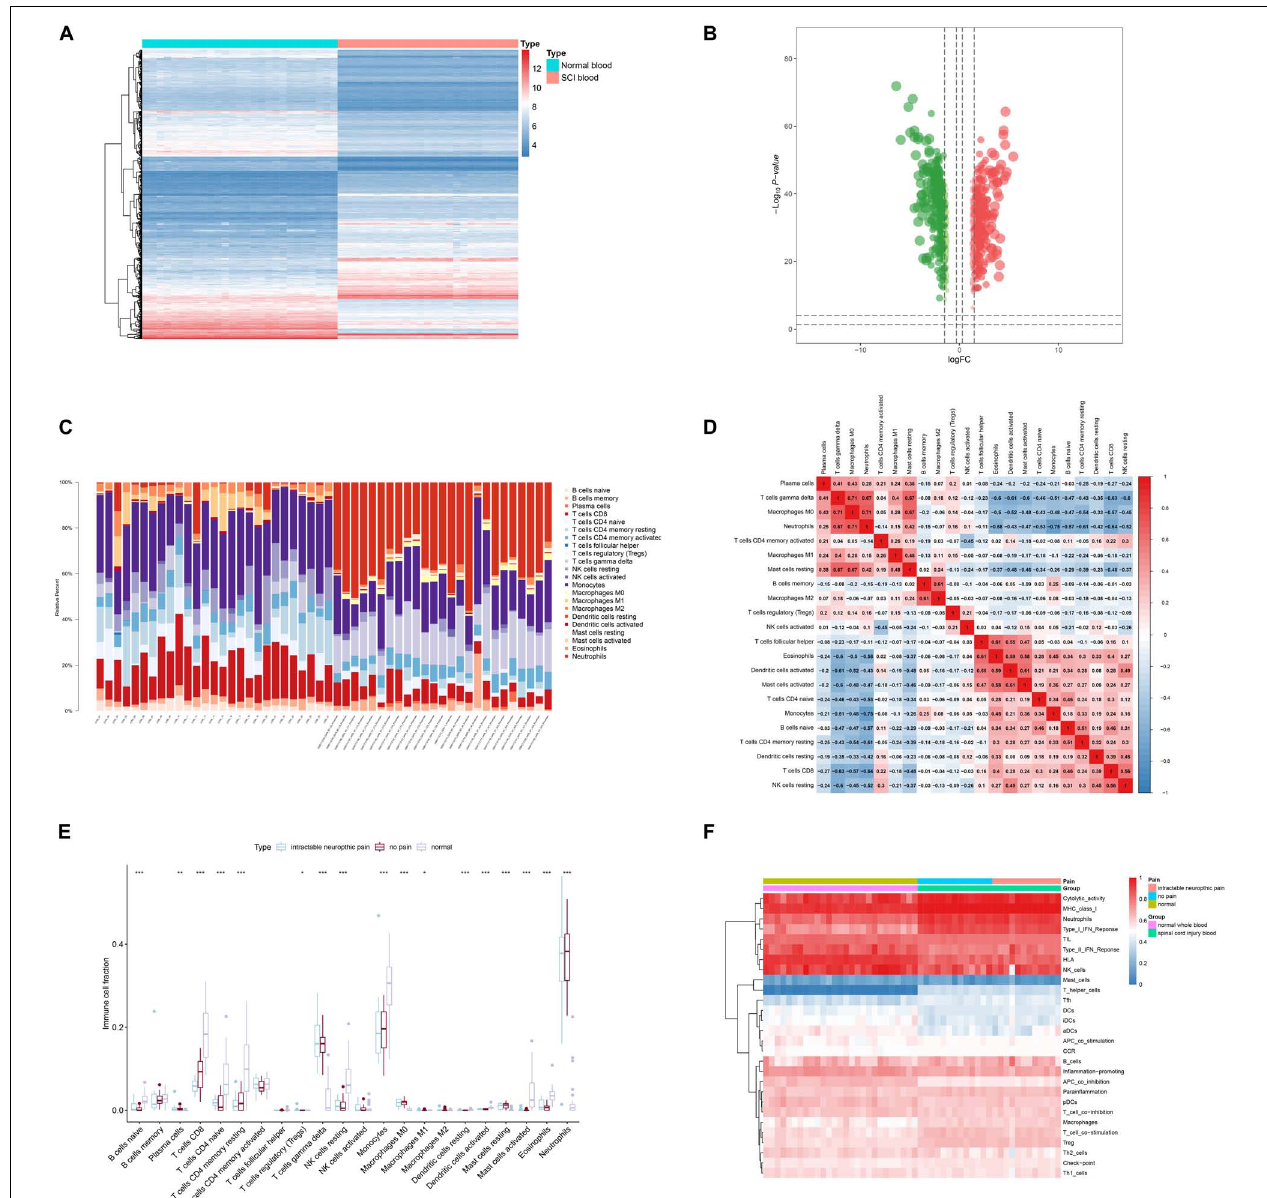
FIGURE 4 | Identification of differentially expressed target genes (DETGs) and evaluation of immune cells/gene sets. (A) Heat map showing the expression level of DETGs. (B) Volcano plot showing the p -value and log| FC| value of DETGs. (C) Bar chart showing the percentage of 22 kinds of immune cells from healthy volunteers and spinal cord injury (SCI) samples by cell type identification by estimating relative subsets of RNA transcripts (CIBERSORT). (D) Heat map showing the expression level of 22 immune cells by CIBERSORT. (E) Box plot showing the fraction of 22 immune cells from healthy volunteers and SCI samples by non-parametric tests. (F) Heat map showing the expression level of 28 immune cells/pathways via single-sample Gene Set Enrichment Analysis